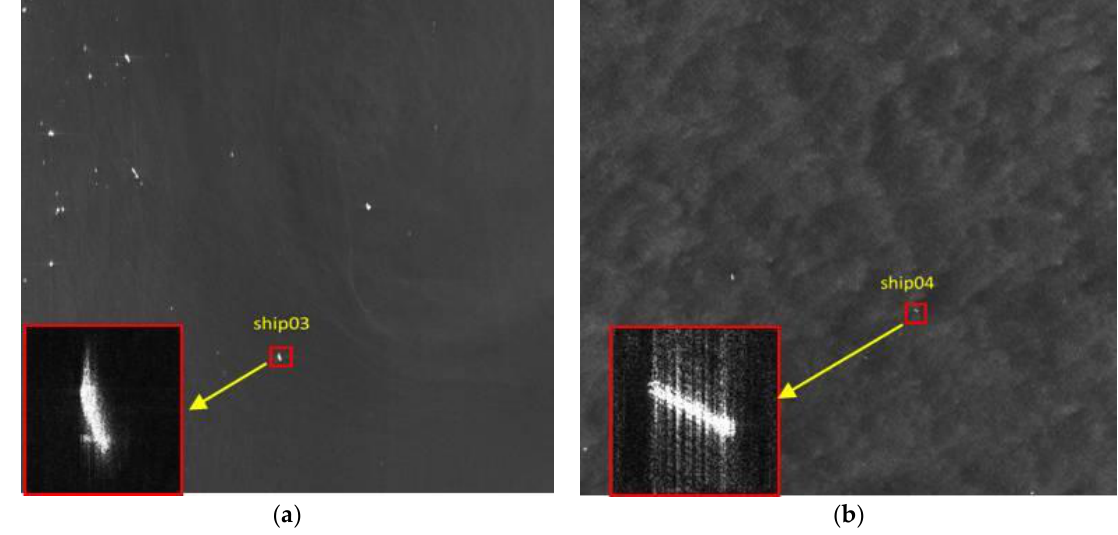
Figure 10. Two defocused ships are detected in Gaofeng-3 images. ( a ) Sub-image of ship03 located in the Gaofeng-3 image; ( b ) Sub-image of ship 04 located in the Gaofeng-3 image. The red rectangles are the zoomed sub-images.